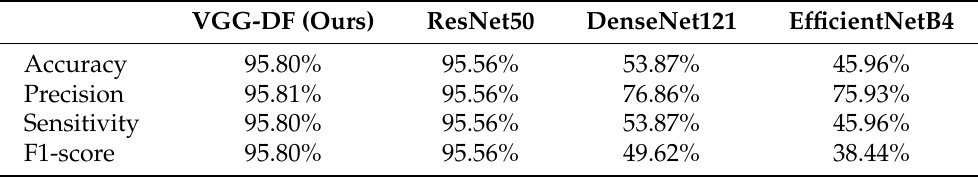
Table 4. Results of different transfer learning models trained on the original